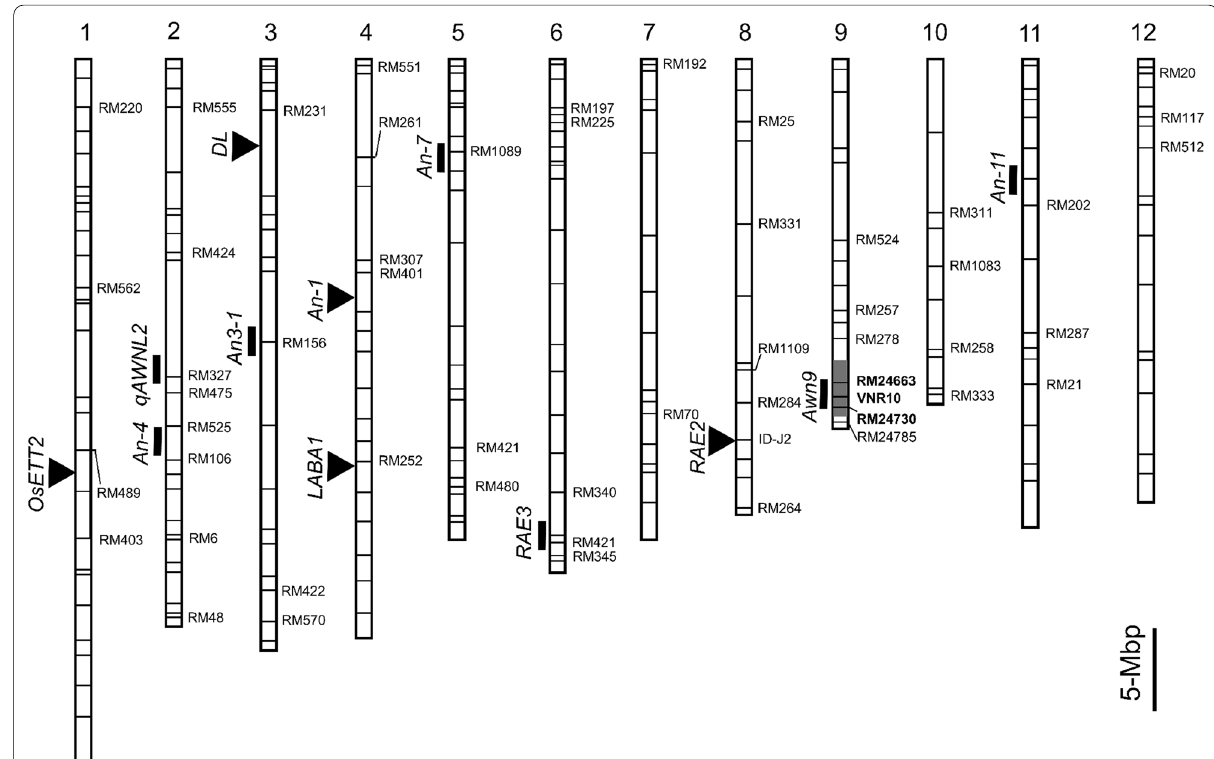
Fig. 3 Distribution of 212 markers and known genes/QTLs for awn development on 12 chromosomes. Polymorphic markers between Milyang23 and NIL4/9 are displayed with names, while bold markers are polymorphic between Hwaseong and NIL4/9. Markers without names indicate monomorphic/ambiguous markers. Cloned genes and QTLs for awn development detected by previous studies are indicated by black triangles and black boxes, respectively, on the left side of chromosomes. Gray box indicates the homozygous O. minuta segment detected by RM24663, VNR10, and RM24730. The bar indicates